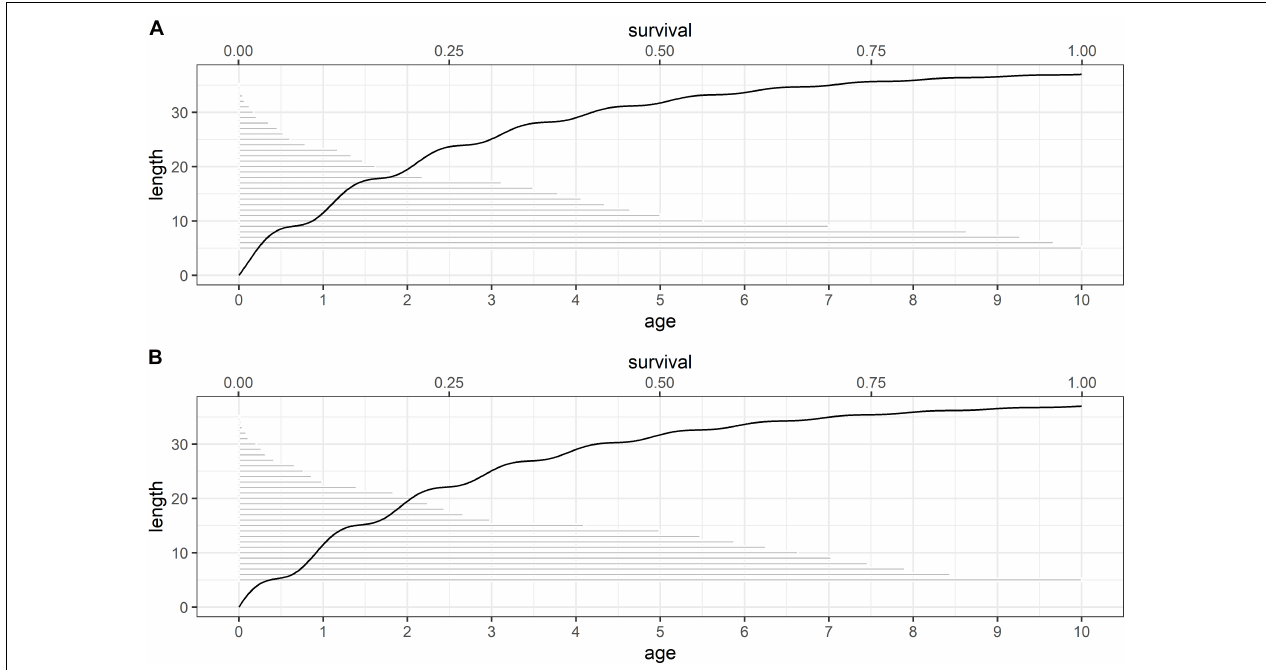
FIGURE 6 | Growth curve and survival rates of each length group for H. otakii . (A) The population has a constant fishing mortality coefficient F = 0.4. C and ts are set to 0.8 and 0.15, respectively. (B) ts is set to 0.95, and other parameters are same as